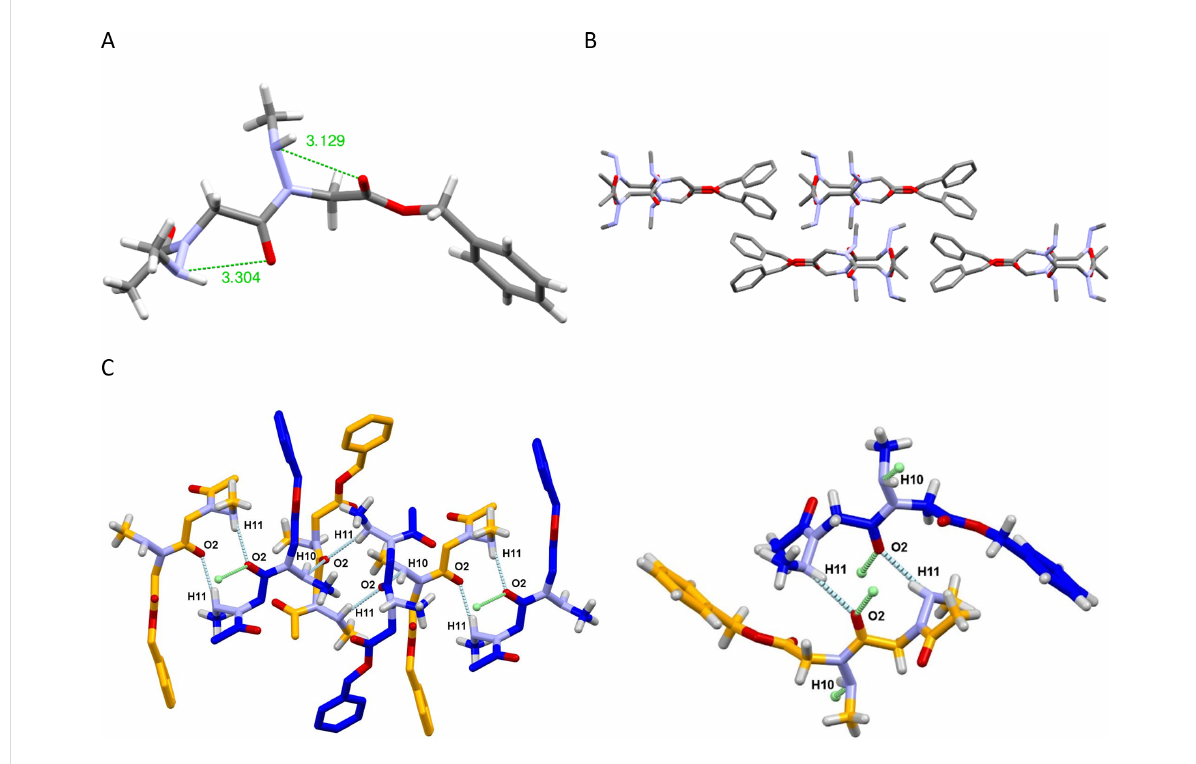
Figure 3: X-ray crystal structure of peptoid dimer 2 : (A) single molecule; (B) unit cell, view along b axis (hydrogen atoms removed for clarity); (C) overview of the hydrogen bonding network (conformation A depicted in blue, conformation B in orange), hydrogen bonds (light blue dashed lines), hanging hydrogen bonds (light green dashed lines).